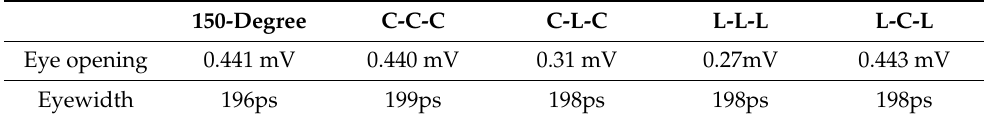
Table 5. The values of the measured eye diagram.